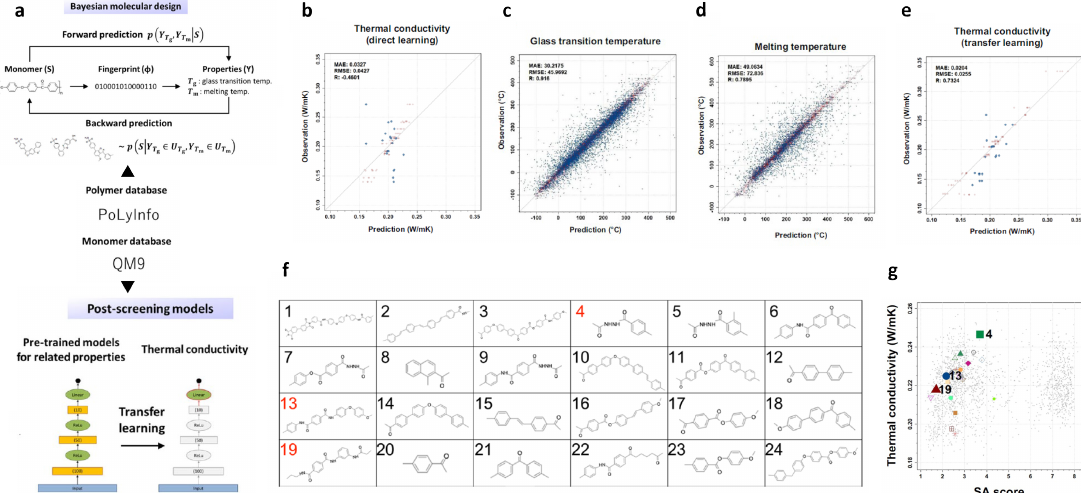
Figure 7. Integrated design for polymers with high thermal conductivity. ( a ) The proposed ML approach for materials discovery; ( b ) the performance of a direct learning algorithm; ( c , d ) validations of the trained linear regression model for glass transition temperature and melt temperature, respectively; ( e ) validation of the transfer learning; ( f ) the screened molecular candidates, in which the number are synthesized in red color; ( g ) validation of the synthesized molecules. The figures are adapted from Reference [106] with permission, copyright 2019 Springer